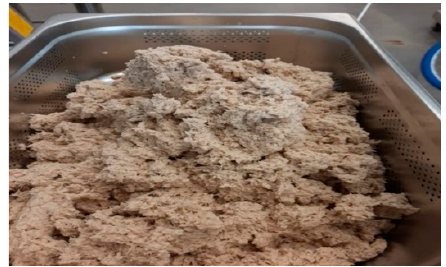
Figure 3. A. oryzae biomass after excess liquid removal .